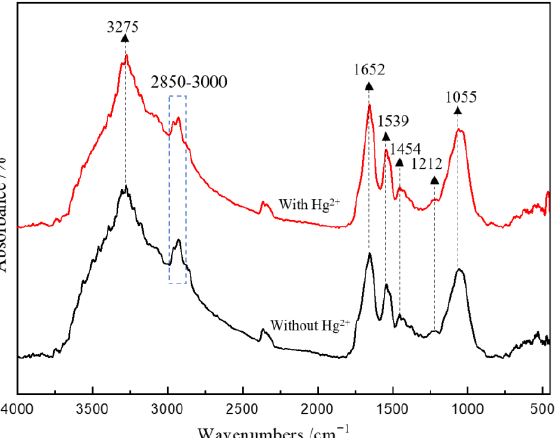
Figure 4. The FT-IR spectra of AMD-enriched microbial cells at day 48 for the groups without and with Hg 2+ .